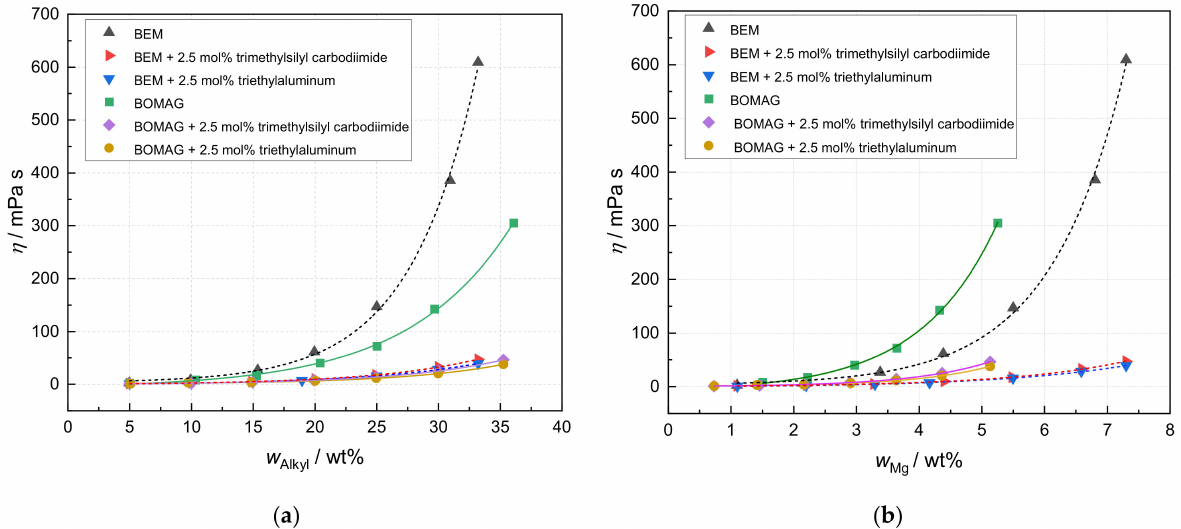
Figure 3. ( a ) Viscosity profiles related to the alkyl concentration for butyl ethyl magnesium (BEM) and BOMAG in heptane (mixture of isomers). Furthermore, the viscosity curves of the two alkyls with the addition of 2.5 mol% triethylaluminum and 2.5 mol% trimethylsilyl carbodiimide are displayed; ( b ) Viscosity profiles for the unmodified magnesium alkyls and modified ones related to the magnesium